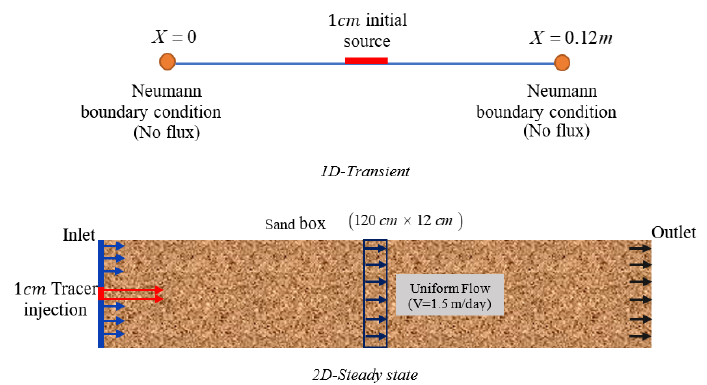
Figure A3. Configuration of benchmark 3.